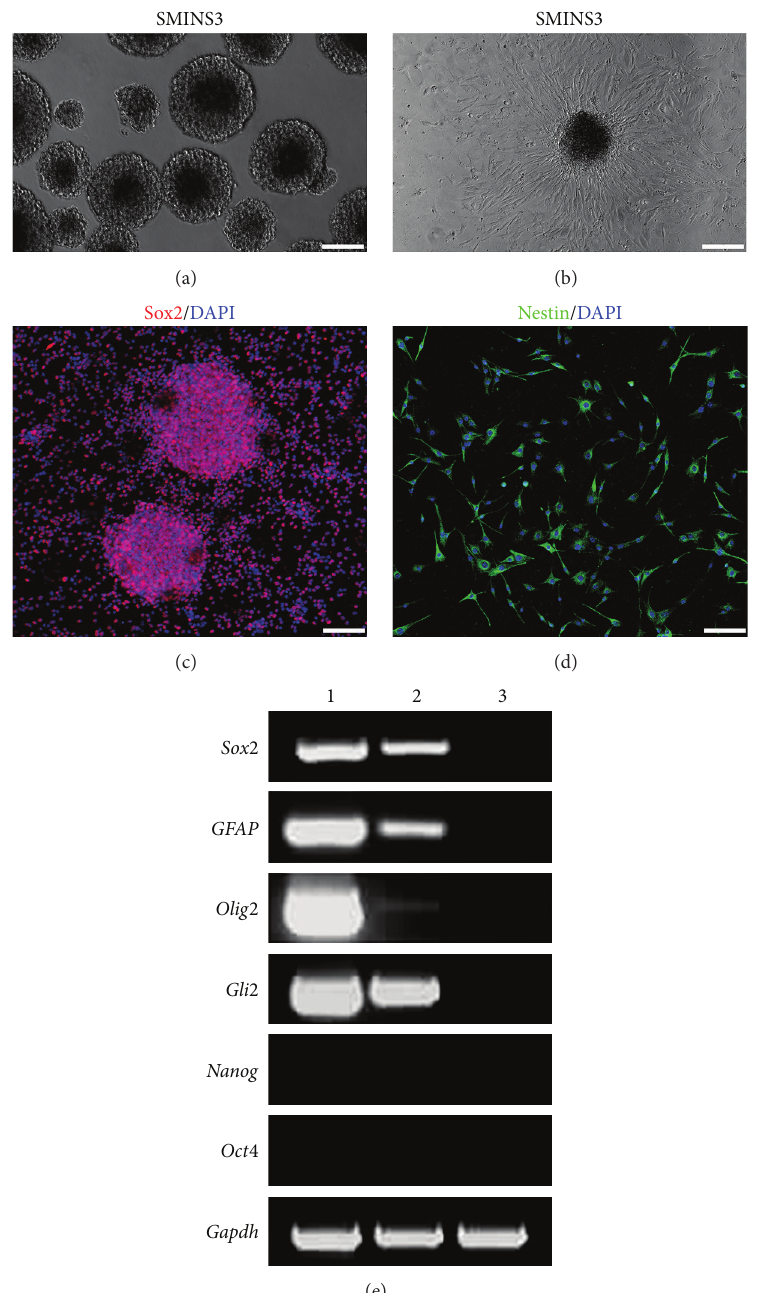
Figure 1: SMINS-TTF-3 cells induced from mouse tail-tip fibroblasts utilizing three small molecules (Bix01294, RG108, and PD0325901). (a) SMINS-TTF-3 neurospheres were cultured in petri dishes under bright field in suspending culture. (b) A SMINS-TTF-3 neurosphere was cultured on matrigel coated dishes under bright field in attaching culture. (c-d) SMINS-TTF-3 neurospheres were dissociated and stained by typical neural stem cell markers Sox2 (red) and Nestin (red) examined by immunocytochemistry. DAPI was used for nuclei counterstaining (blue). (e) Analysis of typical neural stem cell gene expressions by RT-PCR, (1) NS (native neural stem cells), (2) SMINS-TTF-3 (small molecule-induced neural stem cells from TTF with 3 small molecules), and (3) TTF (tail-tip fibroblasts). Scale bar: 100 𝜇